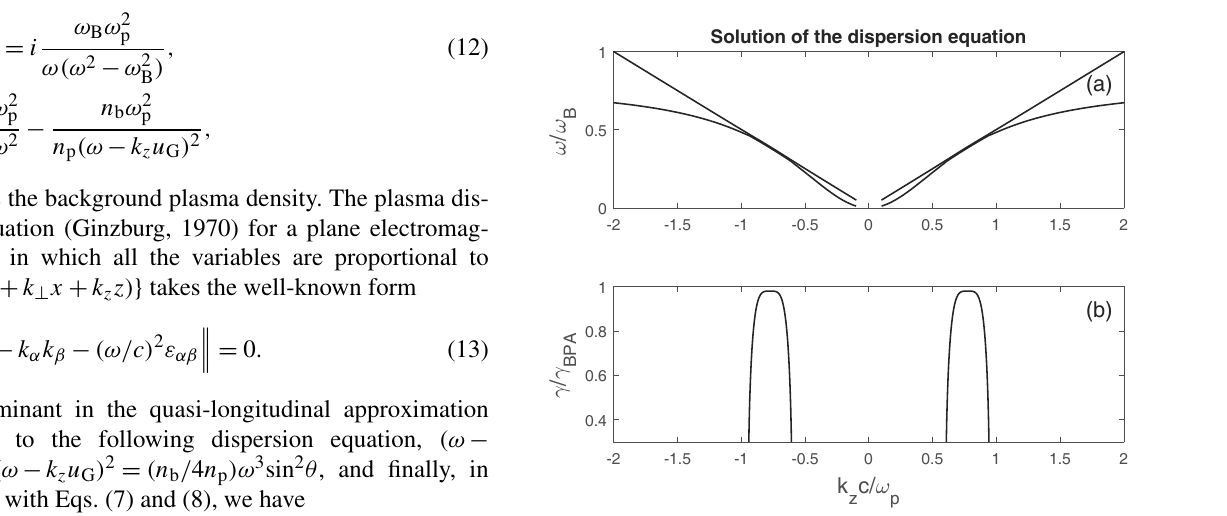
Figure 2. Numerical solution of the dispersion Eq. (14) for n b /n p = 10 − 5 and θ = θ BPA : (a) the frequencies (real part of frequencies) dispersion behavior of the longitudinal wave number; (b) condi- tional growth rate of a short electrostatic pulse as a function of the longitudinal wave